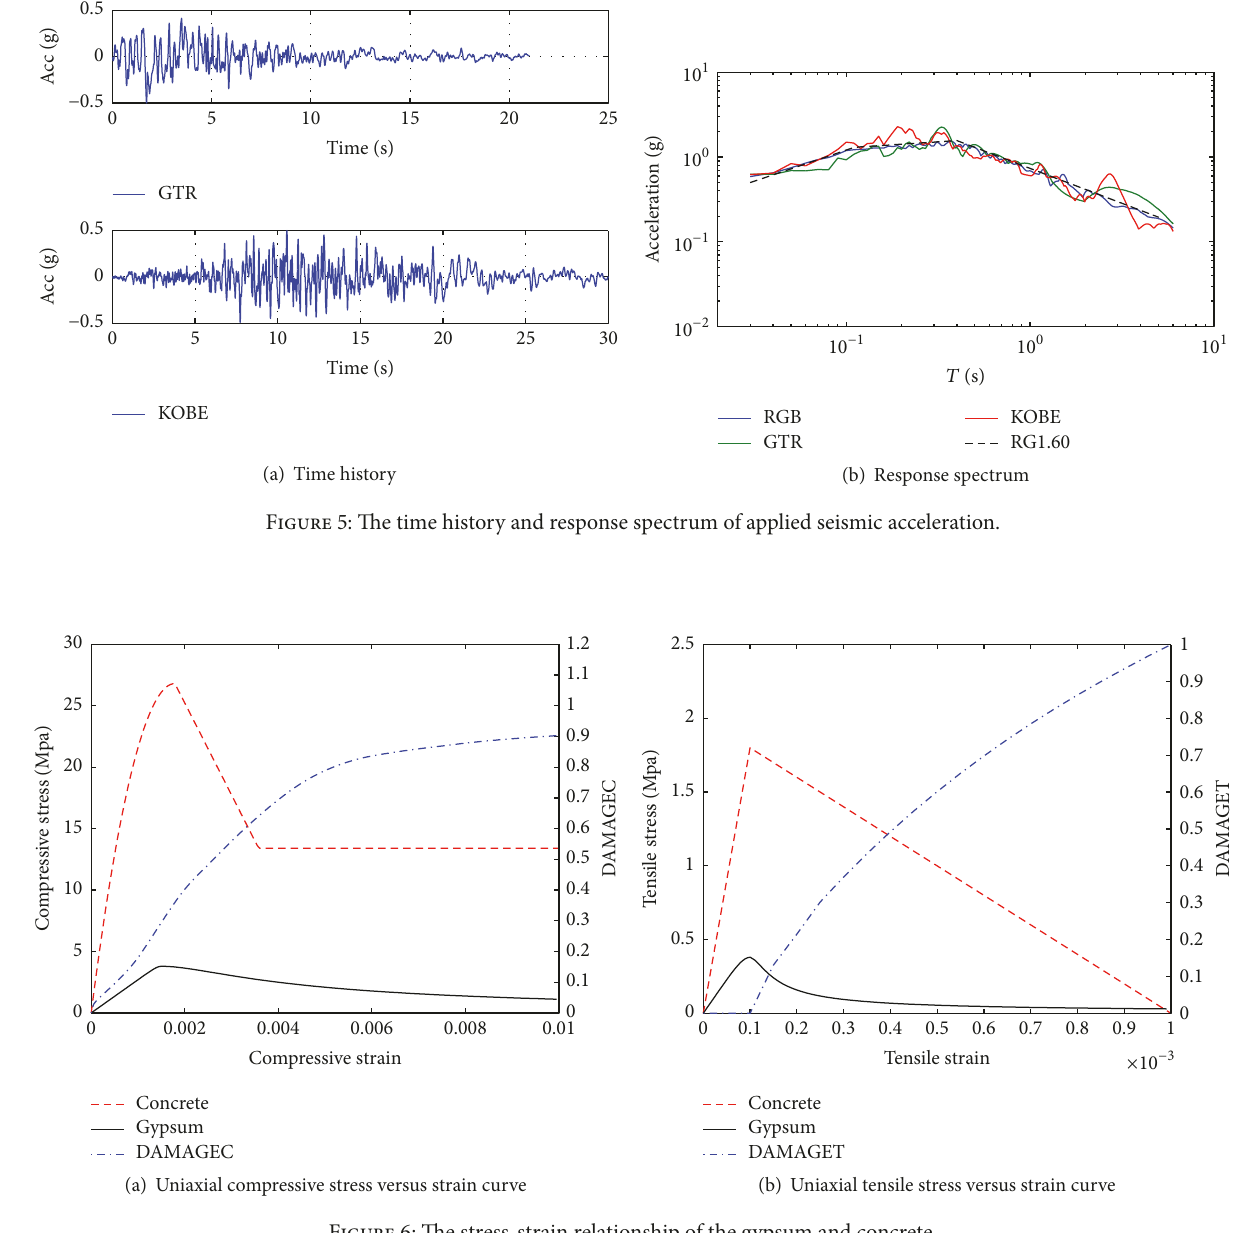
(b) Uniaxial tensile stress versus strain curve Figure 6: The stress-strain relationship of the gypsum and